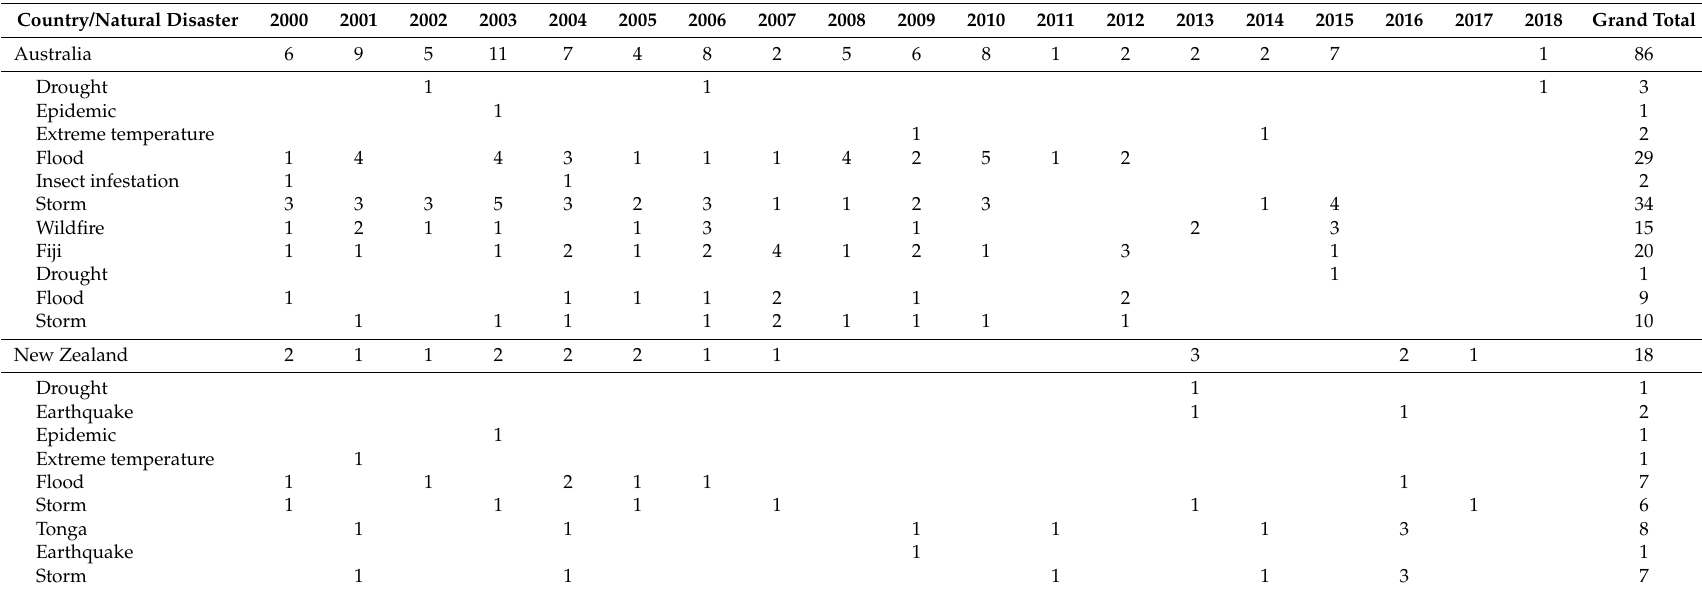
Table 2. Natural disasters of study countries in Oceania 2000–2018